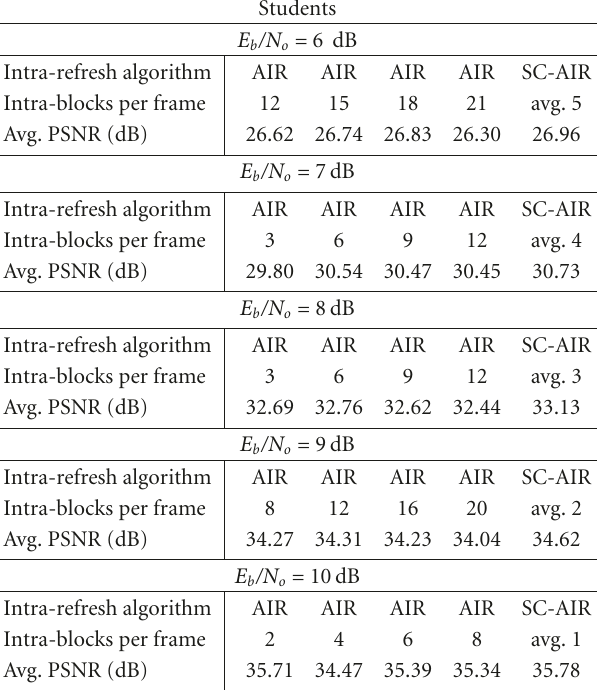
Table 3: Transcoding test results for the “Students” stream using standard AIR and